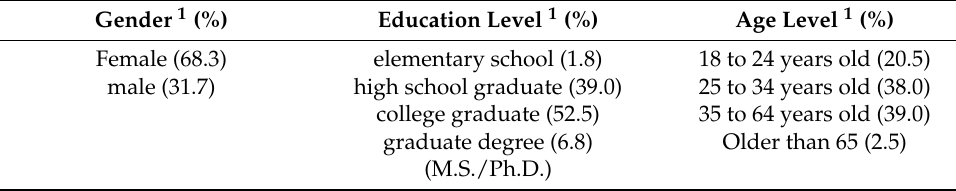
Table 1. The consumer demographic